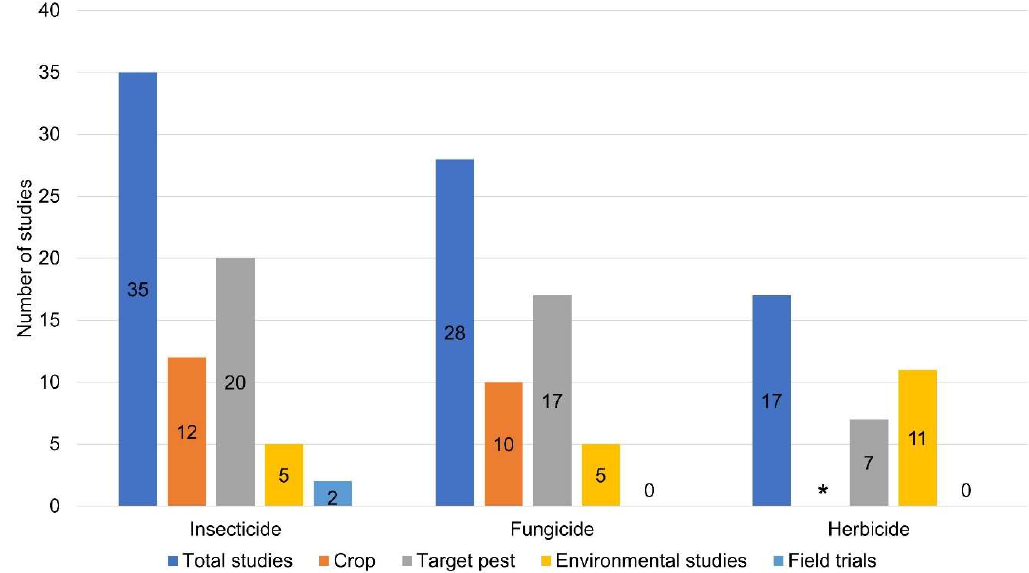
Figure 2. Studies conducted on insecticides, fungicides, and herbicides (including biocides) loaded onto nanoparticles. Insecticides: 35 studies have been conducted to date, where 12 tested their nano-insecticide on crop plants, 20 against the target pest, 5 on environmental issues, such as non-target toxicity or soil leaching, and 2 trials were done in field conditions. Fungicides: 28 studies have been conducted to date, where 10 tested their nano-insecticide on crop plants, 17 against the target pest, 5 on environmental issues, such as non-target toxicity or soil leaching, and no trials have been conducted in field conditions. Herbicides: 17 studies have been conducted to date, where 7 were tested against the target pest, 11 on environmental issues, such as non-target toxicity or soil leaching, and no trials have been conducted in field conditions. * Crop host experiments were not included, since some herbicides are non-selective.